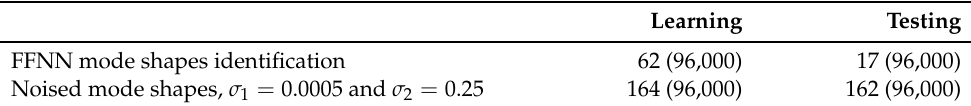
Table 3. Number of wrong feedforward neural network (FFNN) identification cases (among all considered